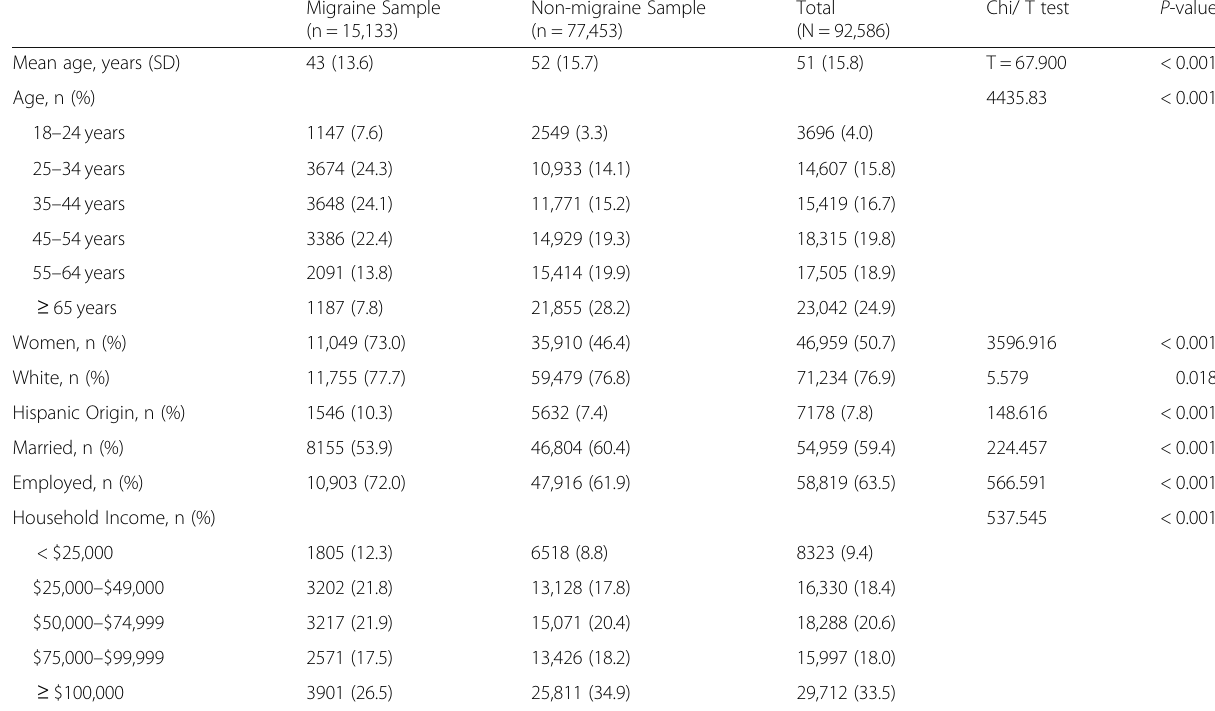
Table 1 Baseline demographics for the migraine ( n = 15,133), non-migraine ( n = 77,453) and total ( N = 92,586) sample